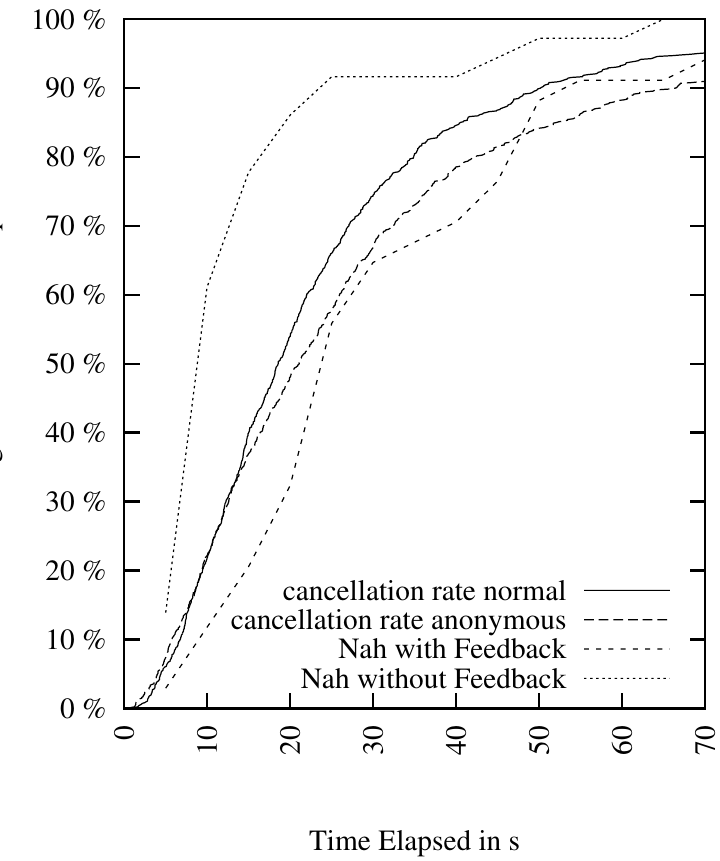
Figure 9. Cancelation Rate of Different